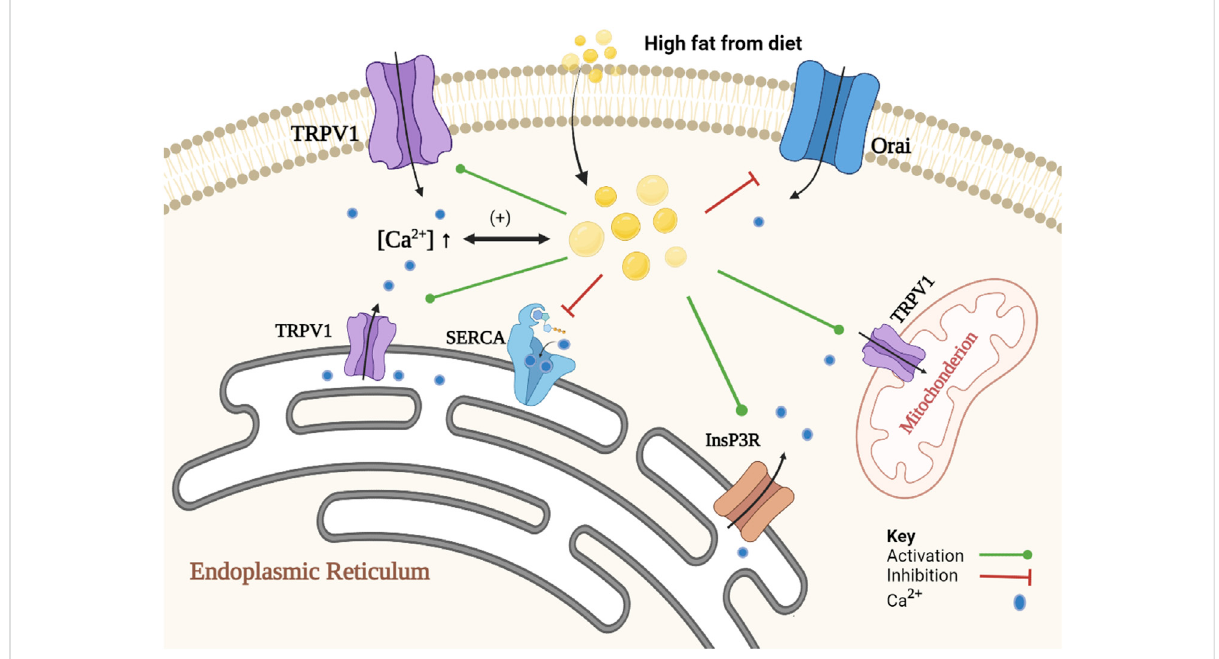
FIGURE 1 Schematic representation of the association of Ca 2+ and lipid accumulation in steatotic hepatocytes. The proposed mechanism is a positive feedback loop between alteration in Ca 2+ homeostasis and formation of cytoplasmic lipid droplet. Alteration in Ca 2+ homeostasis promotes lipid synthesis andinhibits lipiddegradation.An increase in[Ca 2+ ]iinhibitsautophagyofcytoplasmiclipid droplets, andadecreaseinSOCEactivitycauses inhibition of lipolysis, and an increase in [Ca 2+ ] MT inhibits beta-oxidation pathway. In contrast, lipids induce changes in Ca 2+ homeostasis through inhibition of SOCE (e.g., Orai) and SERCA2b activities. Lipids also activate InsP3R indirectly and increase the expression of